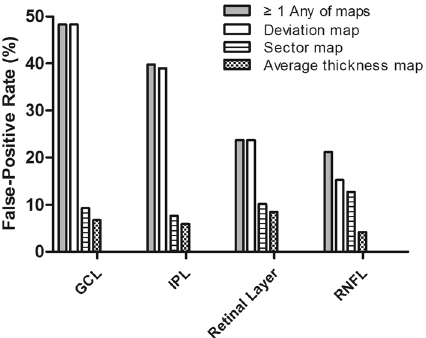
Figure 1. False-positive rates on segmented macular layers (ganglion cell layer [GCL], inner plexiform layer [IPL] and retinal layer) and retinal nerve fiber layer (RNFL) analysis maps of Spectralis